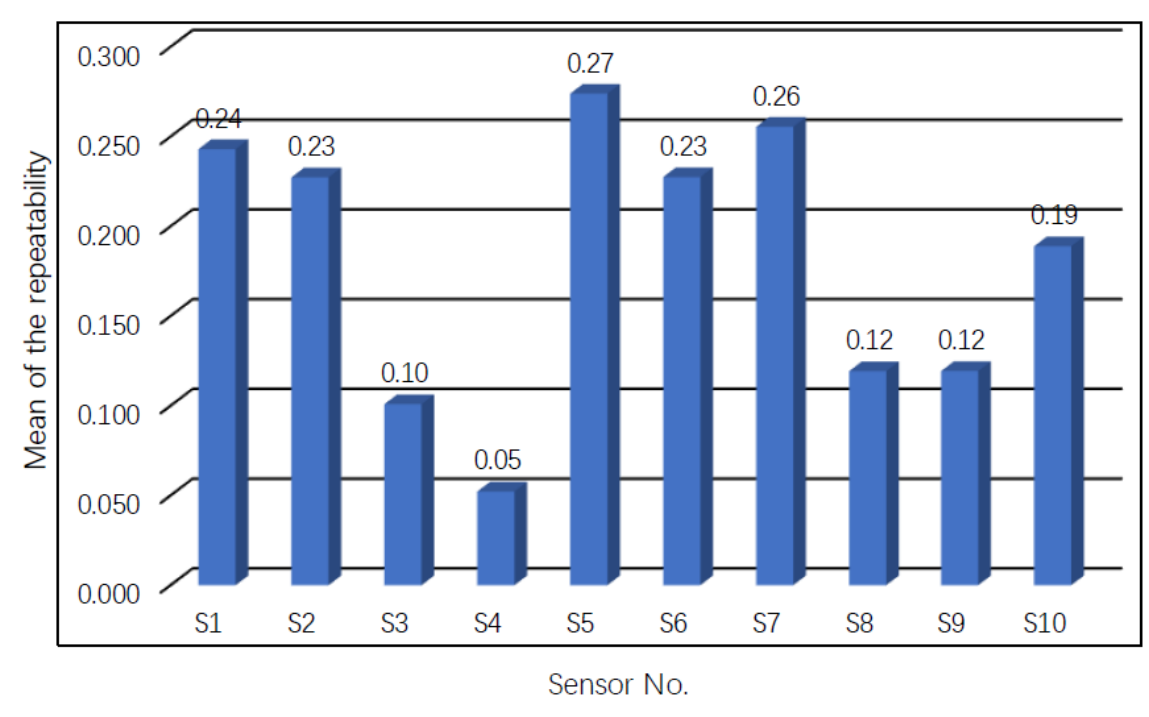
Table 3. Optimization of the initial sensor array based on different evaluation indicators.